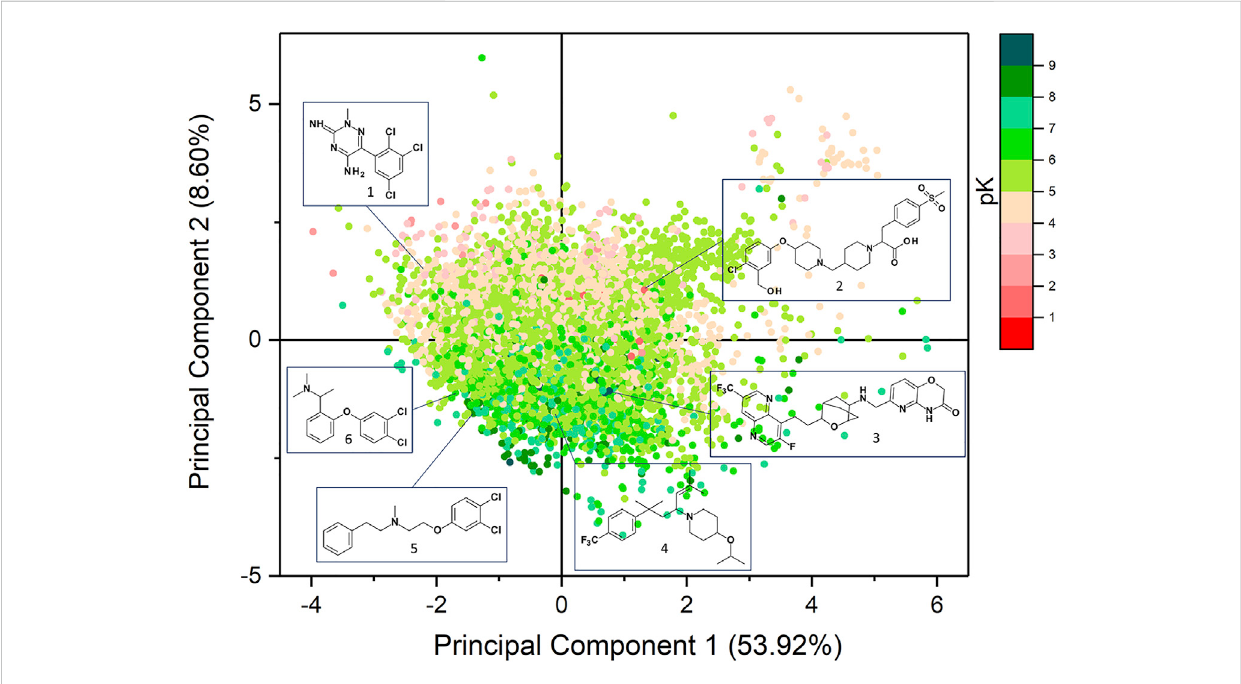
FIGURE 2 Scatter plots of the PCA analysis performed on the datasets used in this